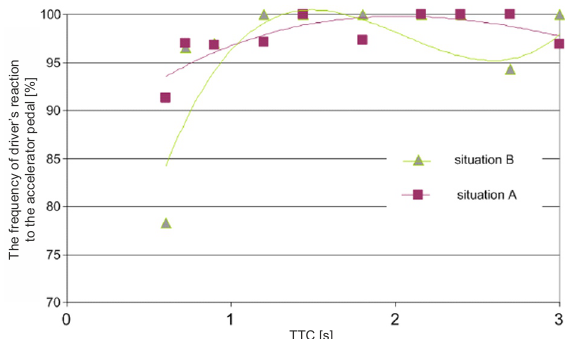
Fig. 16. The values of the frequency of accelerator pedal reaction time